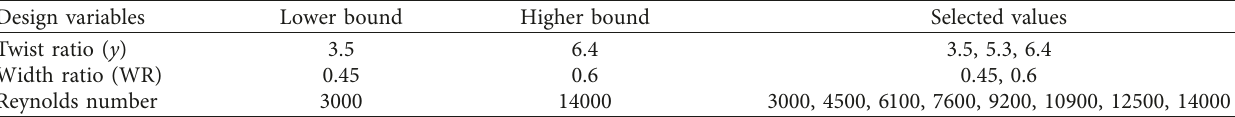
Table 5: Range of design variables and the selected values.